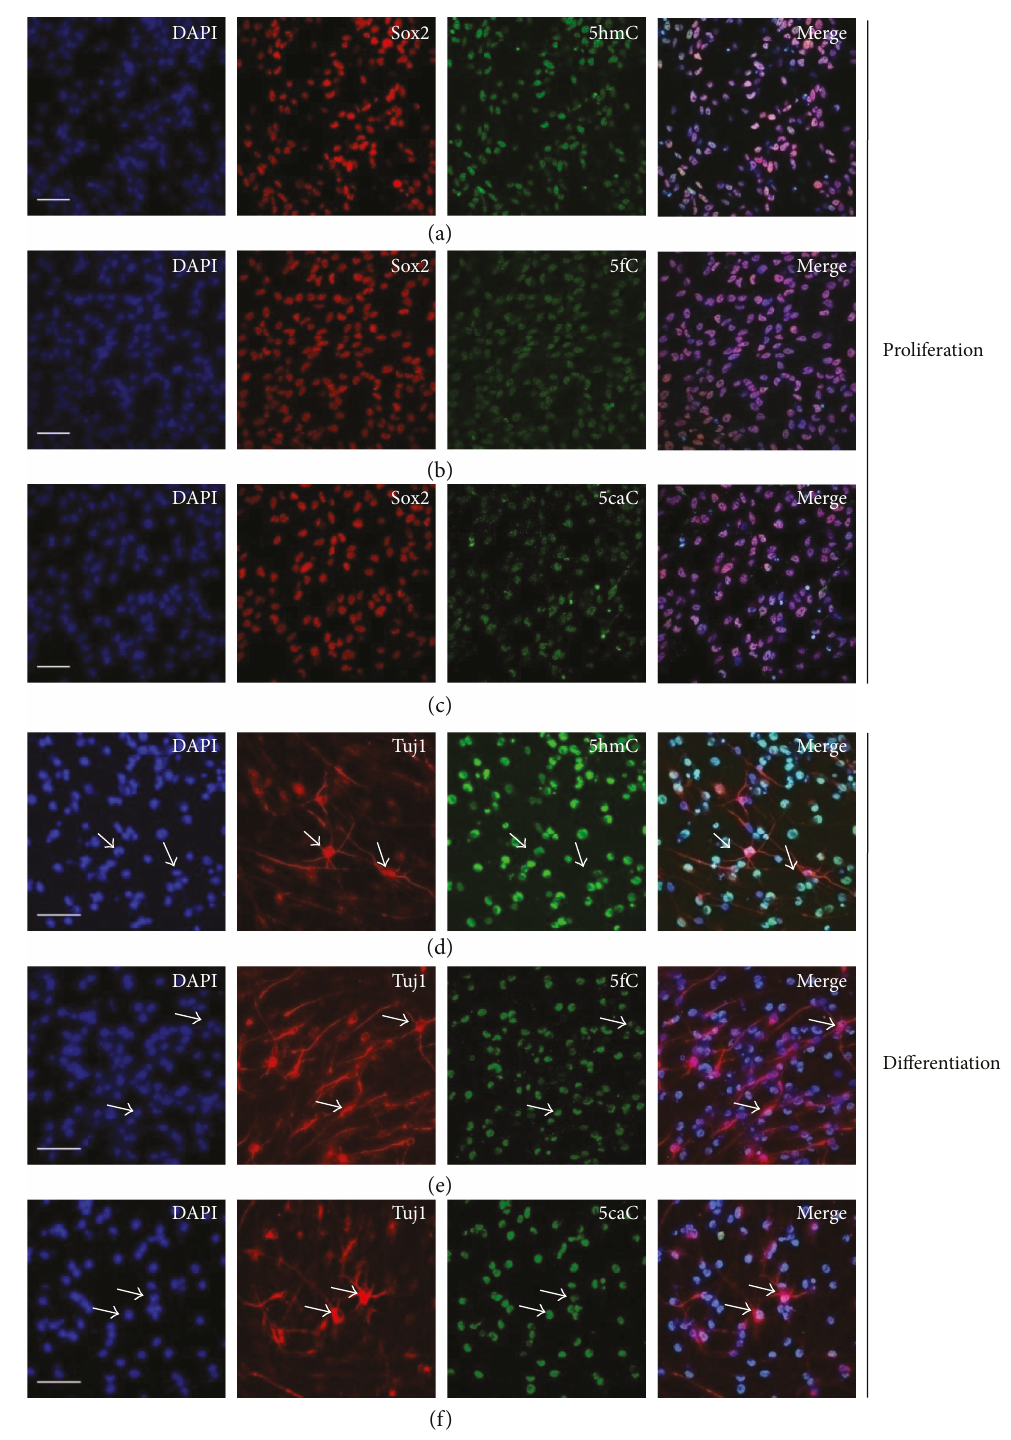
Figure 5: The representative immuno fl uorescence images of 5hmC, 5fC, and 5caC in cultured aNSCs. Immuno fl uorescence of 5hmC (a), 5fC (b), and 5caC (c) in cultured aNSCs. Neuronal cells generated from aNSCs were positive for 5hmC (d), 5fC (e), and 5caC (f). Scale bar, 200 μ